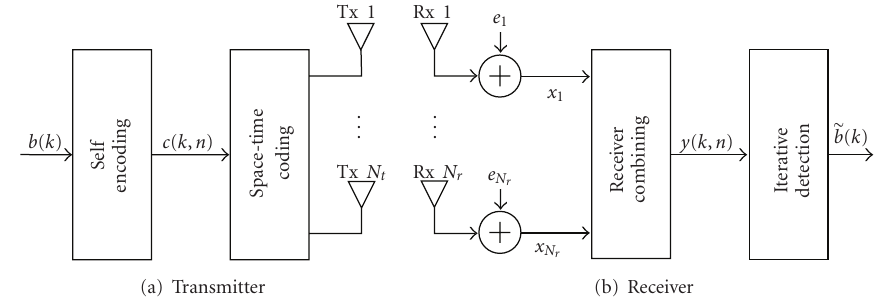
Figure 2: Block diagram of the proposed MIMO-SESS